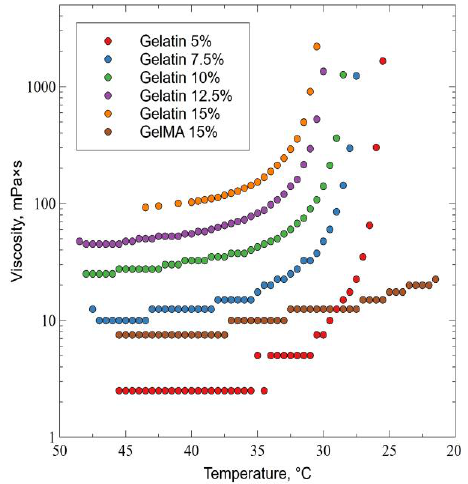
Figure 2. Dependence of the viscosity of hydrogels GelMA 15% and gelatin 5%, 7.5%, 10%, 12.5%, and 15% on temperature.